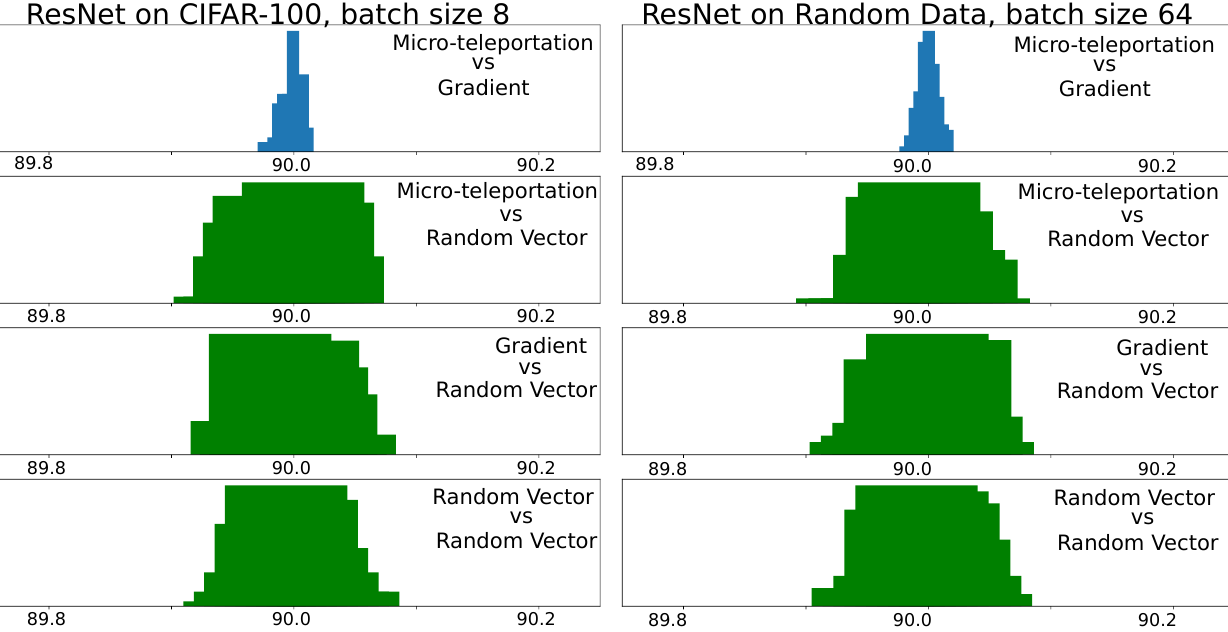
Figure A2. Micro teleportation experiments for ResNet on CIFAR-100 and random